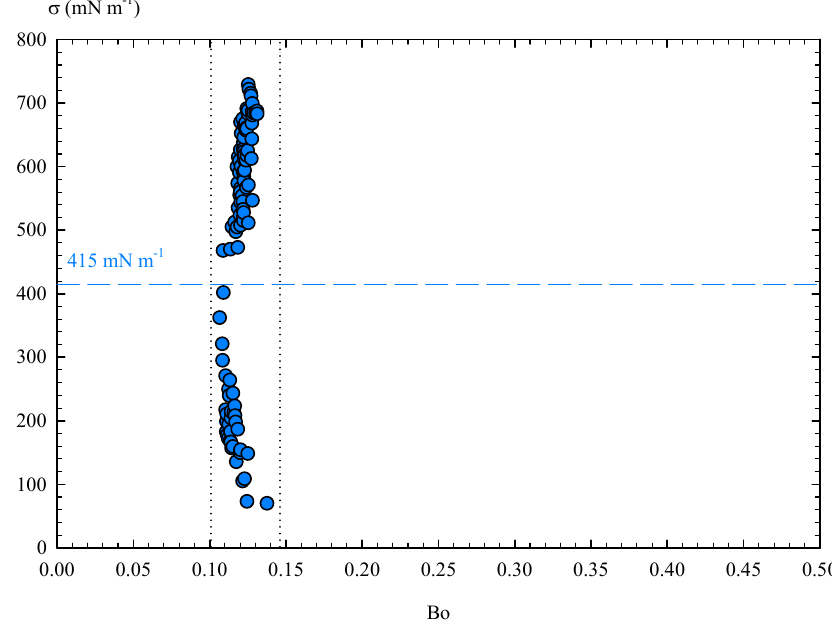
Figure 16. Surface tension of Field’s metal as function of the Bond number